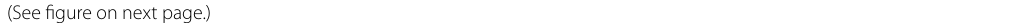
Fig. 7 Anterior caudal vertebrae of A. greppini . 1st caudal vertebra NMB M.H. 278, a anterior, b posterior and c left lateral aspect. Isolated caudal neural spine NMB M.H. 371, possibly belonging to 1st caudal vertebra d anterior, e lateral and f posterior aspect. Photograph and interpretative drawings of 2nd caudal vertebra NMB M.H. 280, g anterior, h posterior, i right lateral, k left lateral and l dorsal aspect. 3rd caudal vertebra NMB M.H.271 m anterior, n posterior, o right lateral, and p dorsal aspect. 4th caudal vertebra NMB M.H. 277 q anterior, r posterior and s left lateral aspect. Photograph and interpretative drawing of 11th caudal vertebra NMB M.H. 276, t anterior, u posterior and v right lateral aspect. Scale bar is 50 mm. Drawings by Serafin Padzera. acdl anterior centrodiapophyseal lamina, art haem articular surface for haemal arch, for vert vertebral foramen, hy hyposphene, hypa hypantrum, lam lamina, pcdl posterior centrodiapophyseal lamina, pocdf postzygapophyseal centrodiapophyseal fossa, podl postzygodiapophyseal lamina, posl postspinal lamina, postzyg postzygapophysis, prcdf prezygapophyseal centrodiapophyseal fossa, prezyg prezygapophysis, prsl prespinal lamina, p trans transverse process, spdl spinodiapophyseal lamina, spol spinopostzygapophyseal lamina, sprl spinoprezygapophyseal lamina,